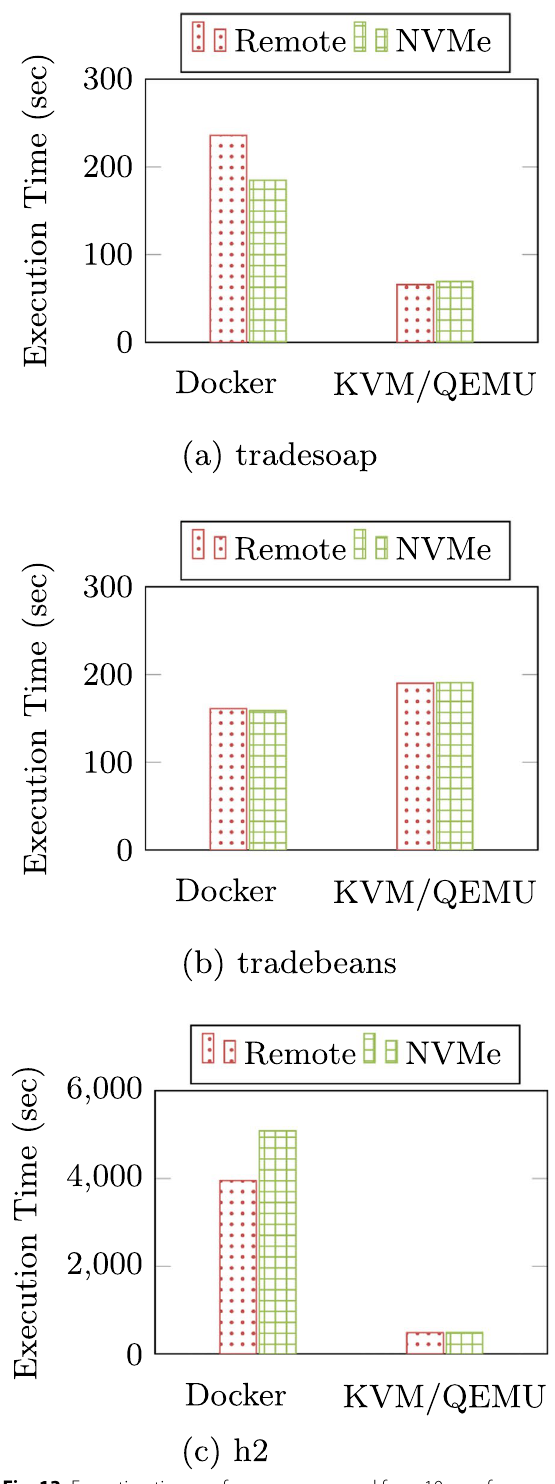
Fig. 13 Execution time performance averaged from 10 runs for DaCapo applications (tradesoap, tradebeans, and h2) in Docker and KVM/QEMU